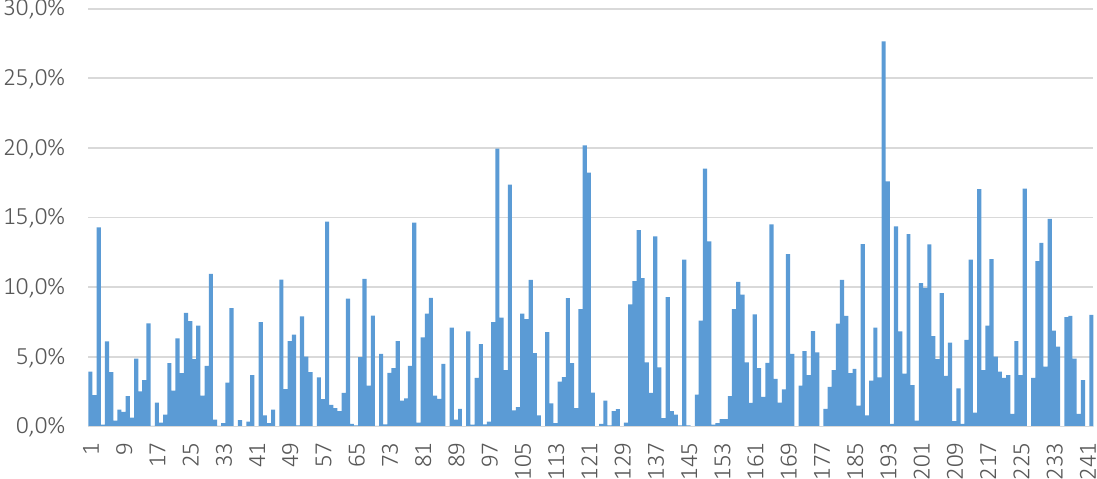
Figure 1. Percentage of samples in which distributions were not